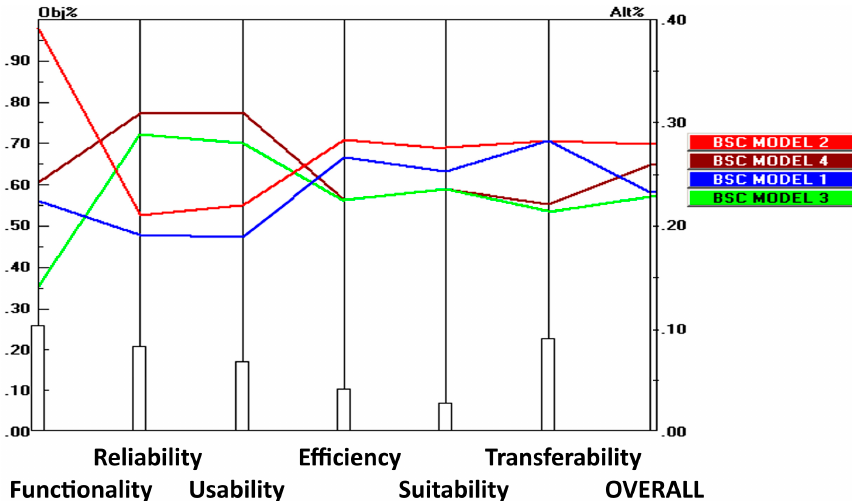
Figure 10. Details on comparing models (obj% = objective goal, in lines; al% = alternative options, in histograms).